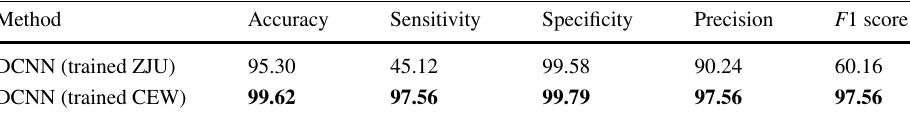
The values indicated in bold in the columns represent the highest